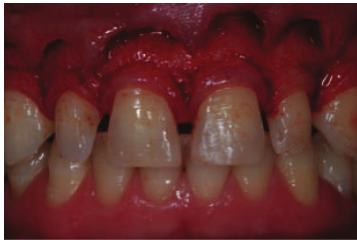
Figure 7: Incision in the registered area and elevation of a full- thickness mucoperiosteal